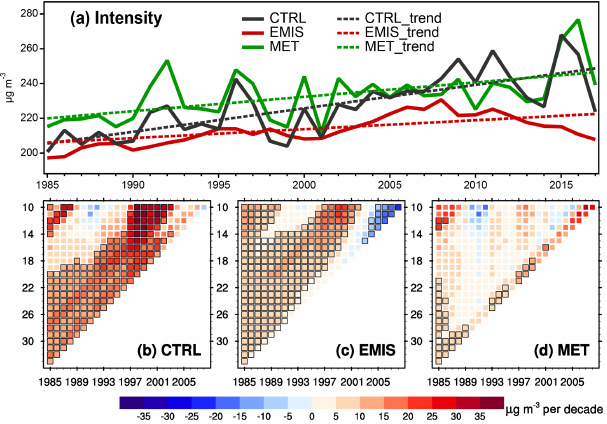
Figure 11. (a) Time series of intensities (µgm − 3 ) of regional SWHD in BTH from the three simulations (CTRL, EMIS, MET) for 1985–2017. (b–e) Time series of linear trends calculated over dif- ferent periods for simulated intensities of the (b) CTRL, (c) EMIS, and (d) MET simulations. The x axis indicates the start year, and the y axis indicates the number of years since the start year during which period the trend is calculated. The filled color in each square shows the calculated trend value, and those marked with black bor- ders are significant above the 95% confidence level.